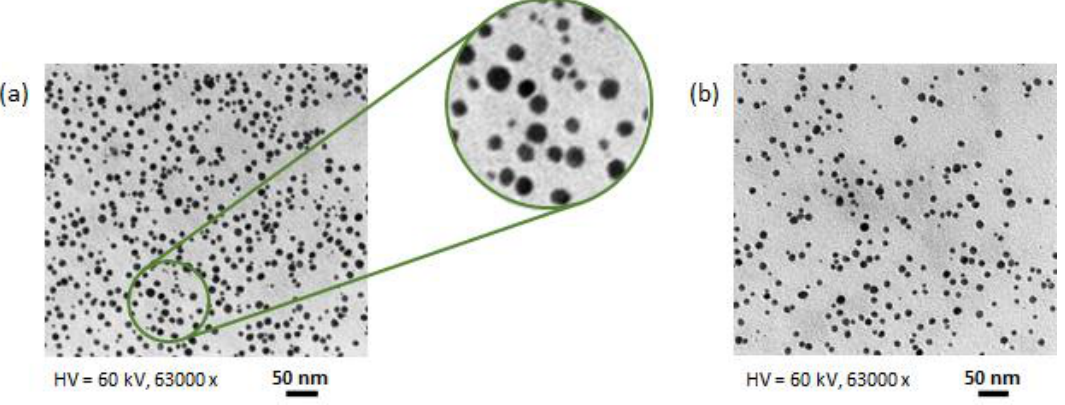
Figure 9. TEM images of the synthesized AgNPs under ( a ) optimal (C = 49.2% v / v ; R = 8 mol/mol; T = 65 °C; pH = 12.2) and ( b ) suboptimal (C = 50% v / v ; R = 5 mol/mol; T = 40 °C; pH = 11) process conditions.